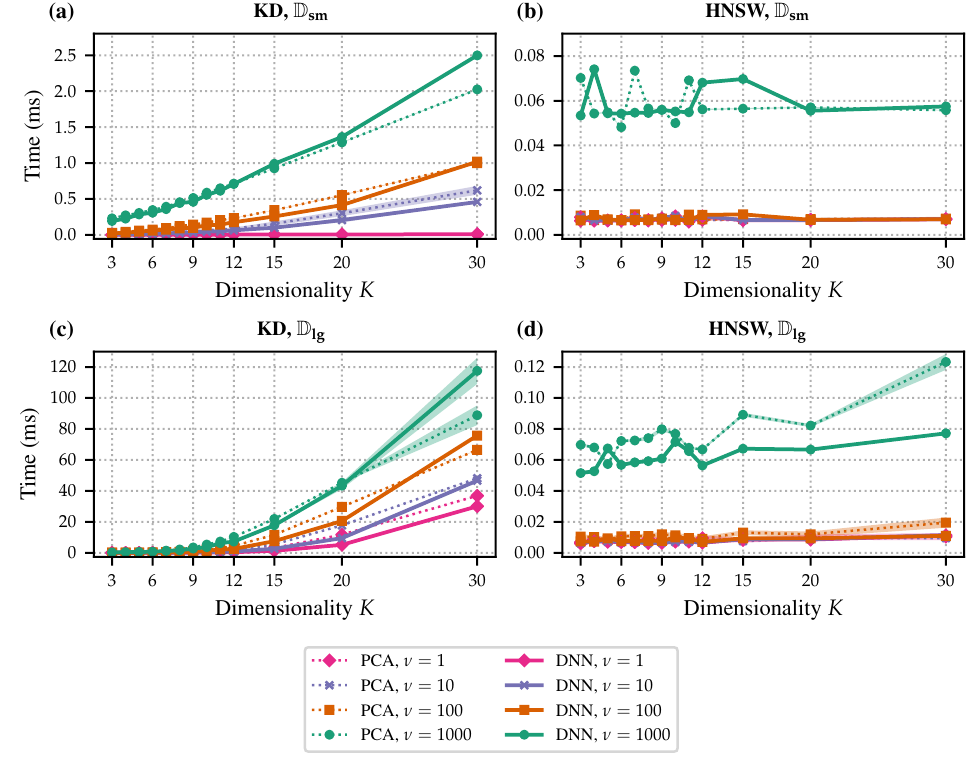
Figure 5. Search runtimes (in ms) for the DNN- and PCA-based embedding approaches. Note the different scale of the vertical axes. The solid lines show the mean and the light areas show ± the standard deviation around the mean for the repetitions of our experiment. Search using ( a ) the KD strategy and D sm , ( b ) the HNSW strategy and D sm , ( c ) the KD strategy and D lg , and ( d ) the HNSW strategy and D lg